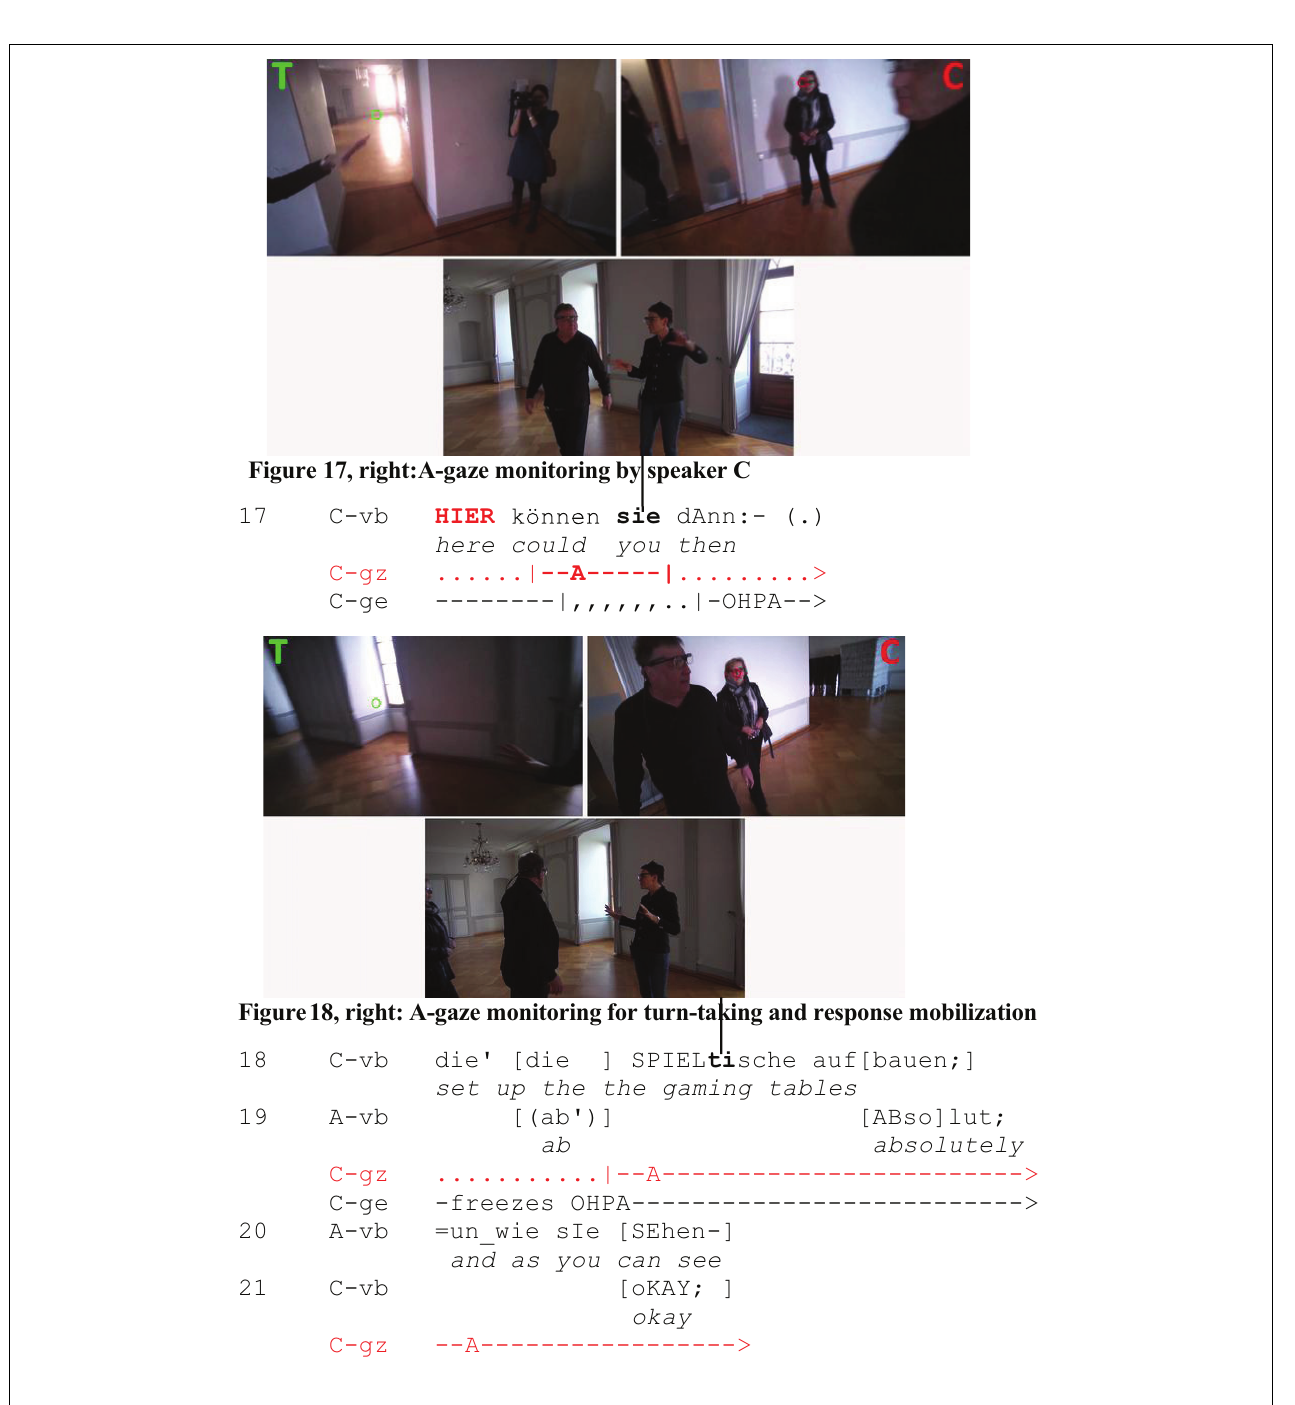
Figure 17, right: A-gaze monitoring by speaker C